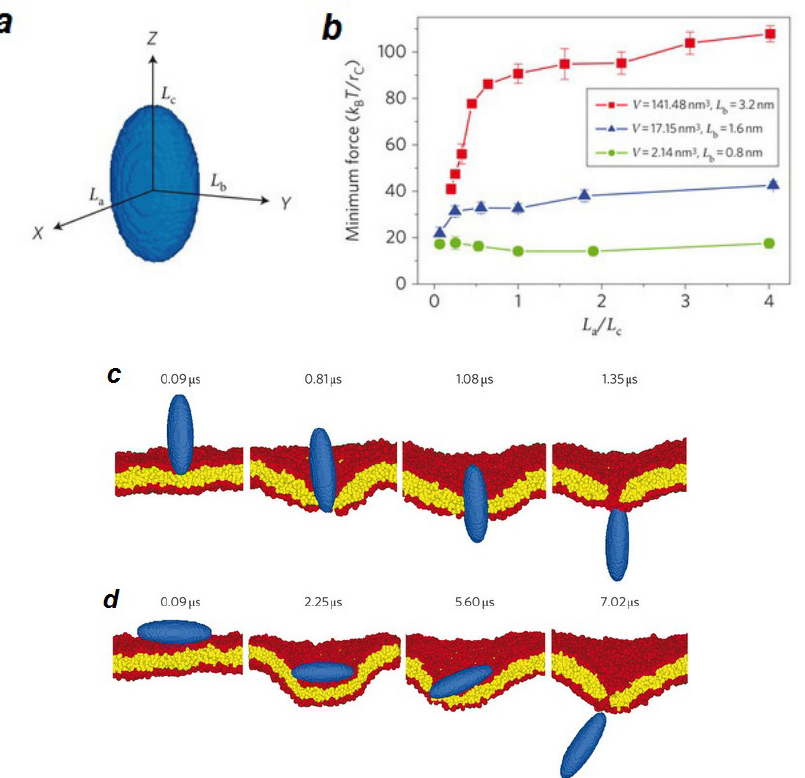
Figure 5. Computer simulation of the translocation of nanoparticles with different shapes across a lipid bilayer ( a ), an ellipsoid particle is schematically illustrated. ( b ) The minimum driving forces needed to pass the ellipsoid particles of different volumes through the lipid bilayer. The shape anisotropy of the nanoparticles is adjusted by changing the aspect ratio ( L L ) at fixed L and volume. r is the force range. ( c , d ) Snapshots of a / c b c computer-simulation of the translocation of the particle with vertical ( c ) and horizontal ( d ) initial orientations. L 1.6 nm, L 3.2 nm and L 6.4 nm ( c ); L 6.4 nm, L 3.2 nm a = b = c = a = b = and L 1.6 nm ( d ). Blue, ellipsoid; red, lipid heads; yellow, lipid tails. Figure is adapted c = from [214] with